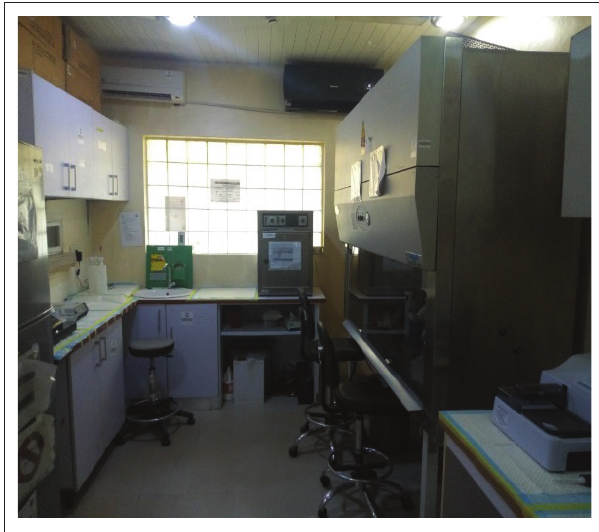
FIGURE 4: Sample inactivation room with a biosafety cabinet, Edo state, Nigeria,